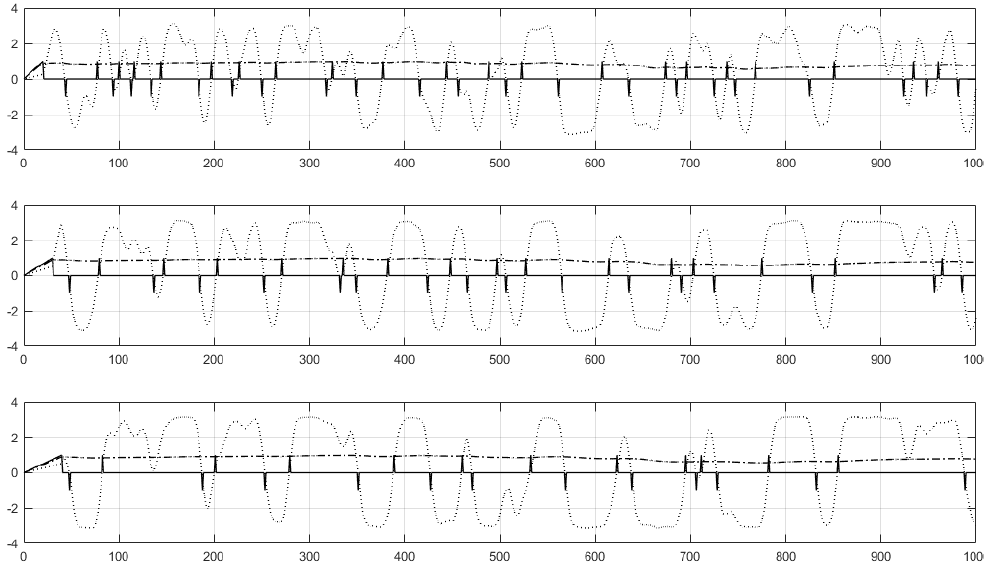
Figure 7. Example graphical outputs from function Backtester. Each plot shows the post-filtered (for T = 10) LVR λ σ [ n ] (dotted line), the pre-filtered time series u n after normalisation (dot-dashed line) and z c [ n ] (solid line) which identifies the zero-crossings of λ σ [ n ] . The plots provided are for the